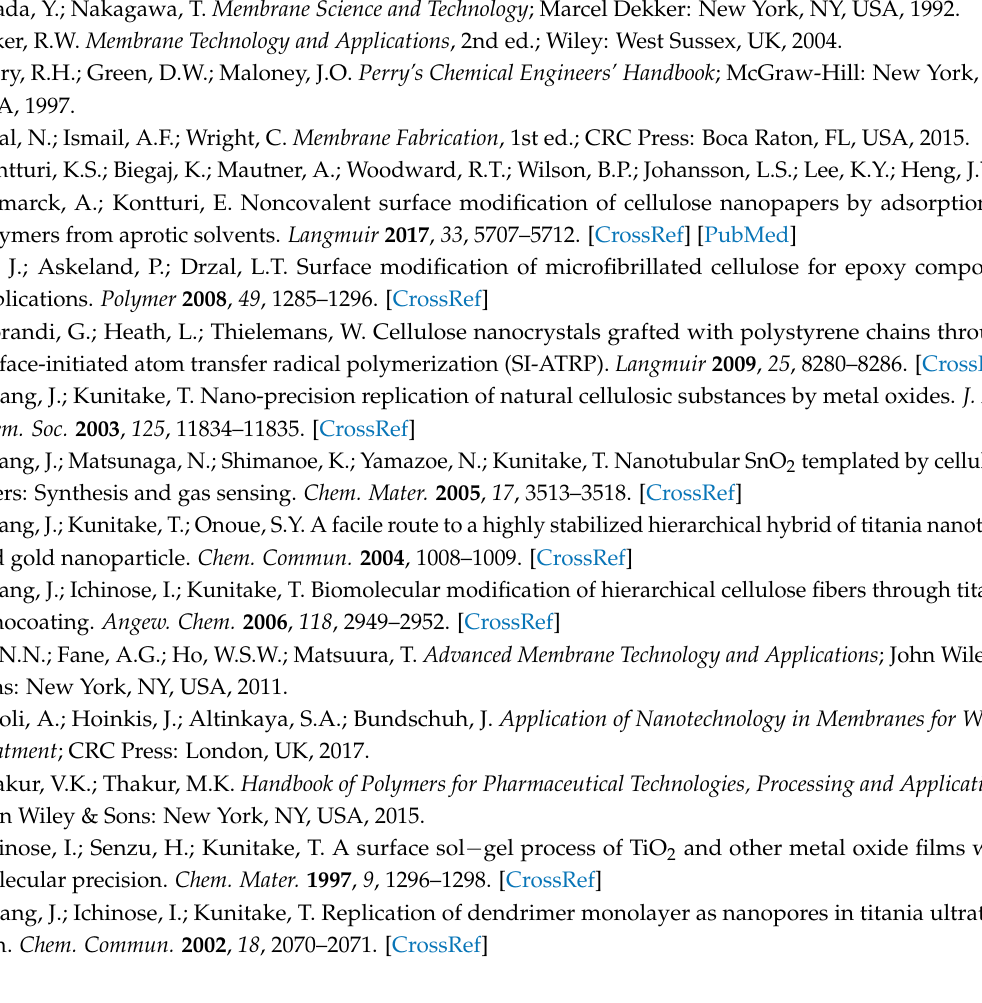
Figure S1: Photographs of (a) TiO2-coated cellulose nanofibers stocked in aqueous media, (b) after adding Au nanoparticles, (c) on-going filtration to capture Au nanoparticles, and (d) Au nanoparticles captured by the TiO2-coated cellulose nanofibers after the filtration; Figure S2: FE-SEM micrograph showing morphology of the cellulose nanofibers without the TiO2